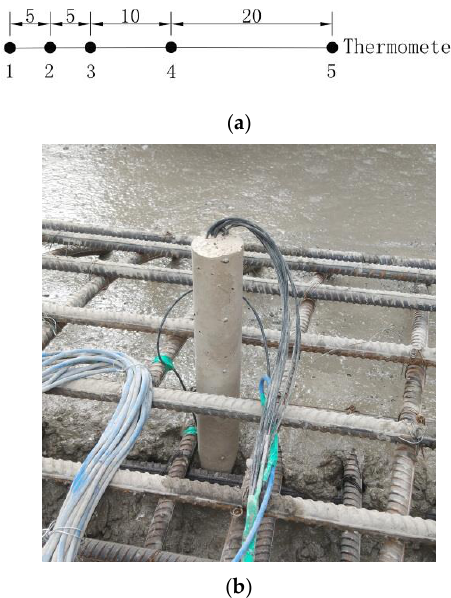
Figure 2. Arrangement of the thermometer string: ( a ) spacing of thermometers (cm); ( b ) concrete column.